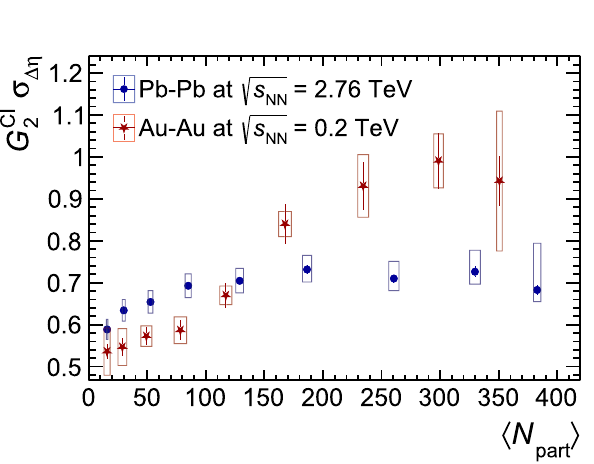
Fig. 2 Longitudinal width, σ (cid:8)η , of the G CI matednumberofparticipantsmeasuredinAu–Aucollisionsat 200 GeV [16] and in Pb–Pb collisions at reported by the STAR and ALICE collaborations, respectively. Error bars and error boxes represent statistical and systematic uncertainties, respectively